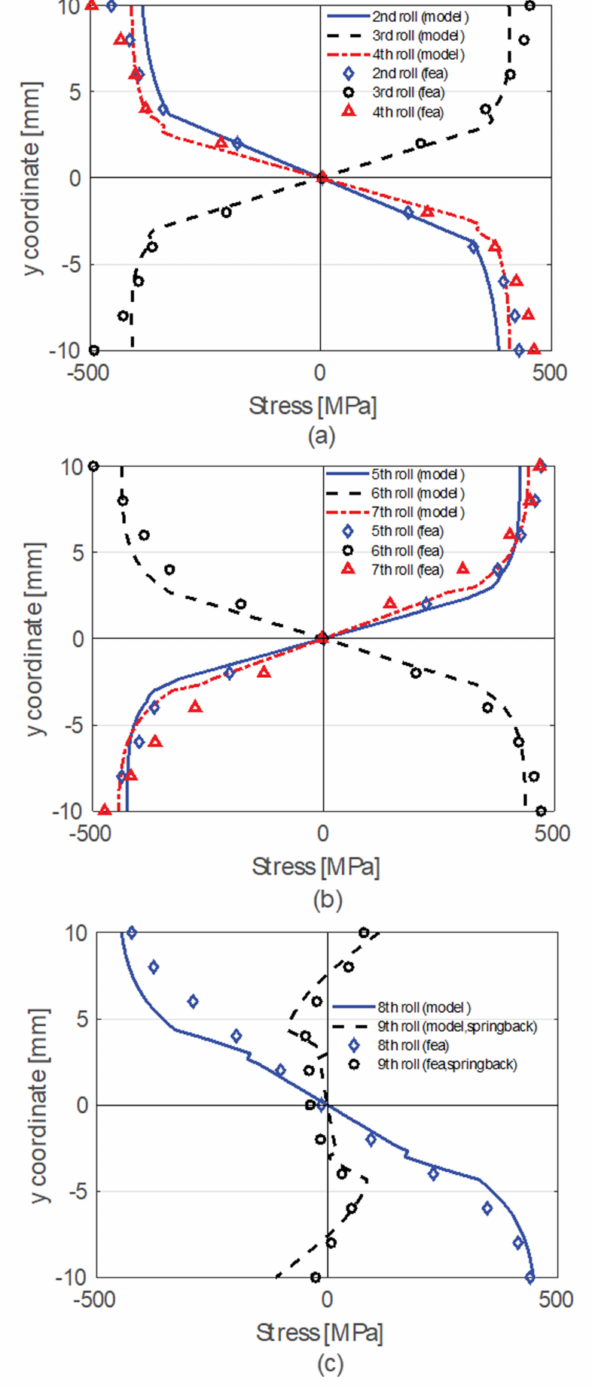
Figure 11. Stress distributions of the strip at ( a ) rolls 2, 3, and 4; ( b ) rolls 5, 6, and 7; ( c ) rolls 8 and